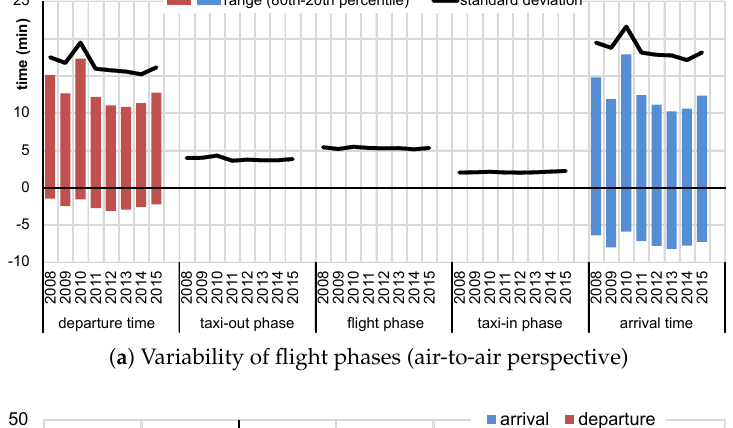
Figure 1b. All stakeholders (airlines, airport, network manager, air navigation service providers) play a role on the system punctuality performance.